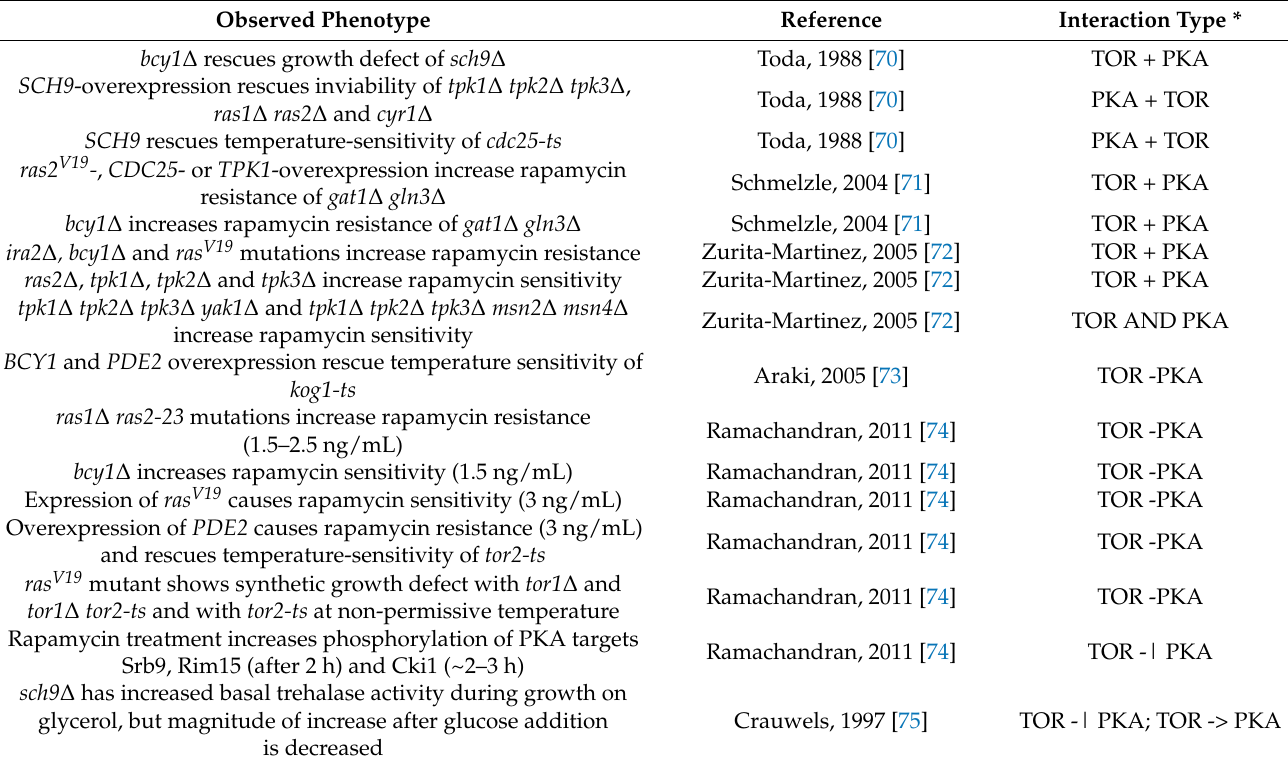
Table 1. Genetic interactions of PKA and TOR